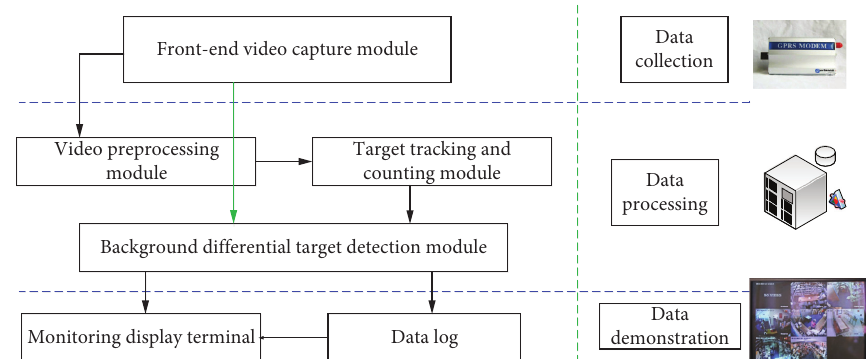
Figure 4: The overall design framework of the monitoring system for training targets.